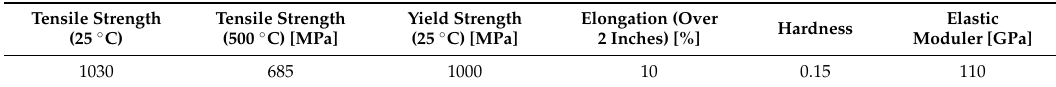
Table 2. Mechanical properties of TC11.